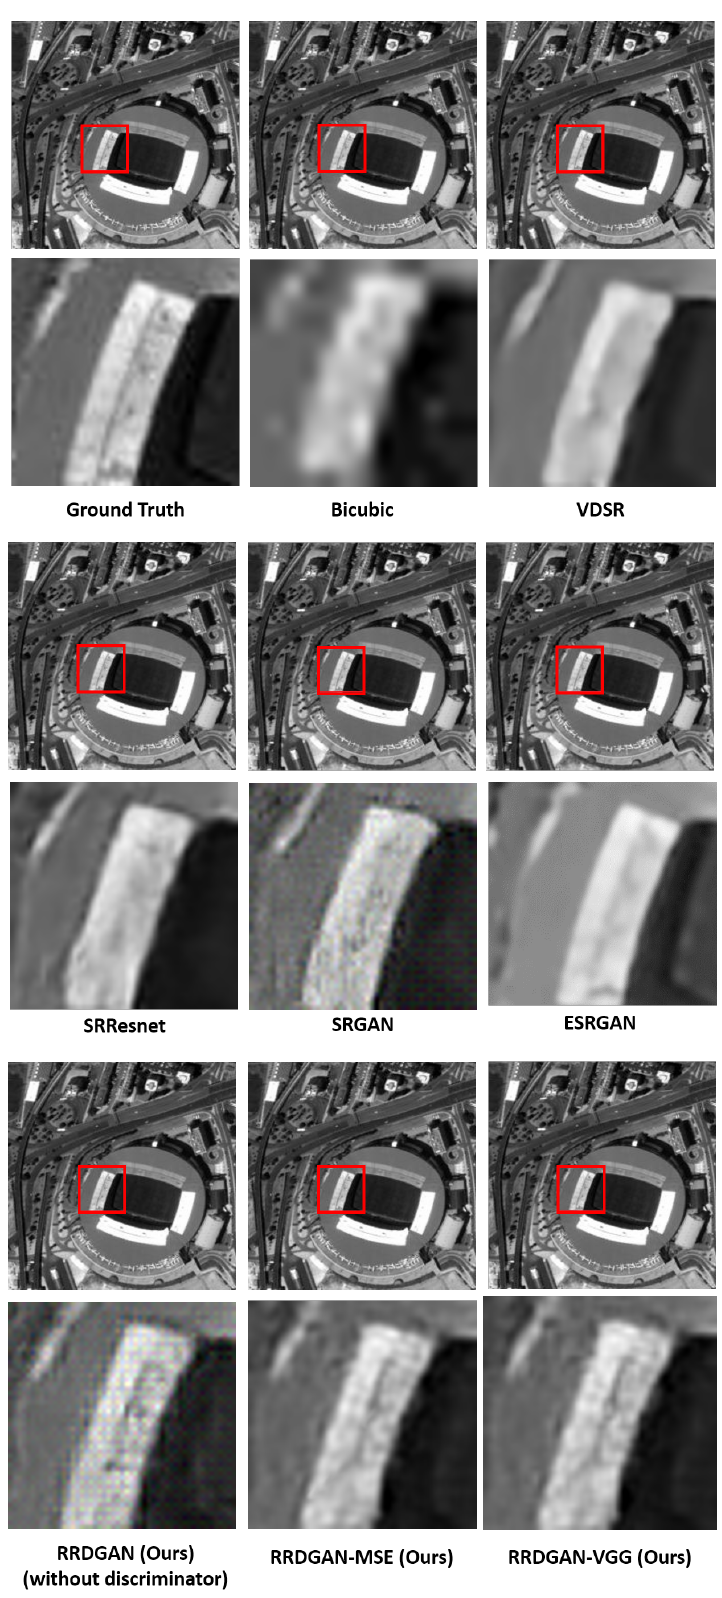
Figure 10. Comparison results among different methods of “Stadium”, scale factor is